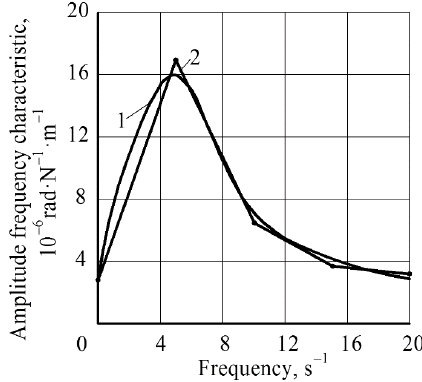
Figure 4. The amplitude–frequency characteristics of the investigated machine-and-tractor aggregate of a modular type. 1—theoretical A t ; 2—experimental A e .